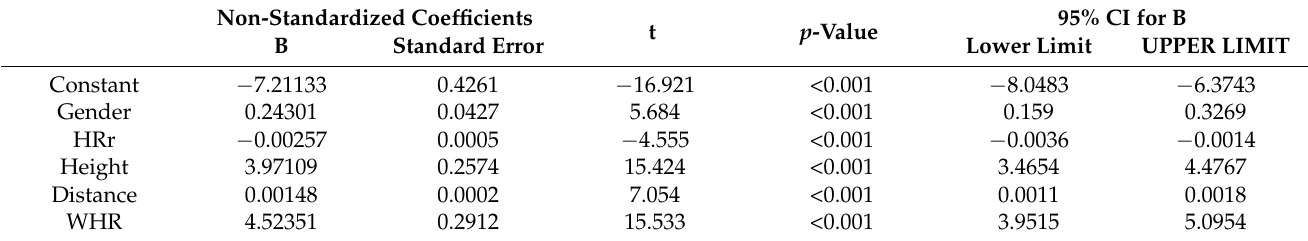
Table 5. Model that explains V ̇ O 2 max (L·min −1 ).